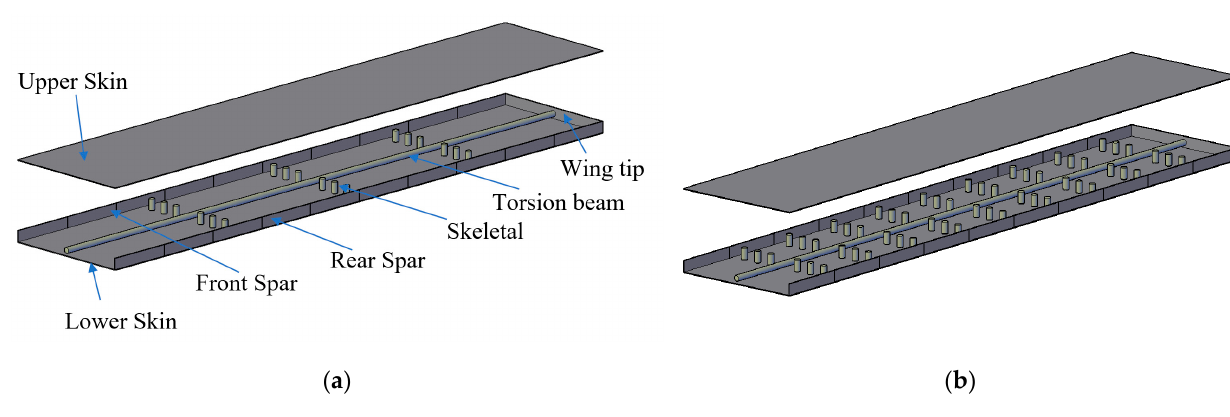
Figure 3. Goland wing modifications in ( a ) Case. I and ( b ) Case. II.